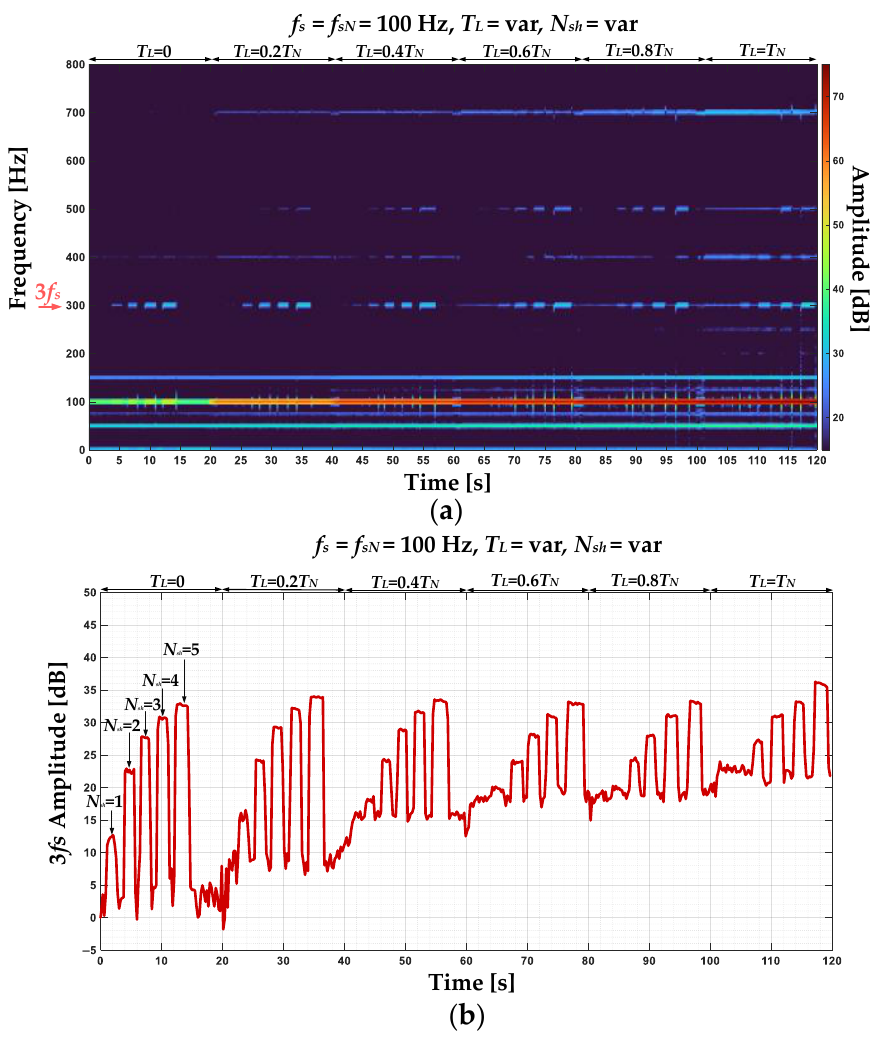
Figure 9. The stator phase currents positive sequence component ( a ) STFT spectrogram and ( b ) 3 f s component amplitude changes during the online operation of the drive system and cyclic momentary short-circuiting of 1 to 5 turns at variable load torques.